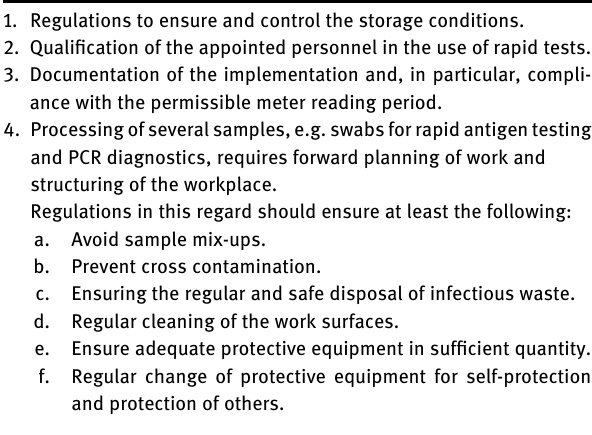
Table  : Quality principles in the application of